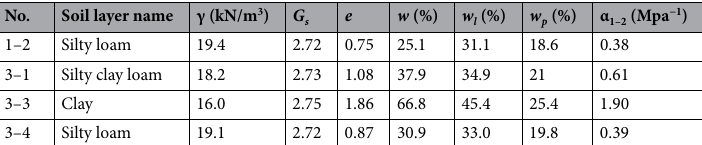
Table 1. Engineering properties of soils at the test site. γ unit weight, G s specific gravity, e void ratio, w natural water content, w l liquid limit, w p plastic limit, α 1–2 coefficient of